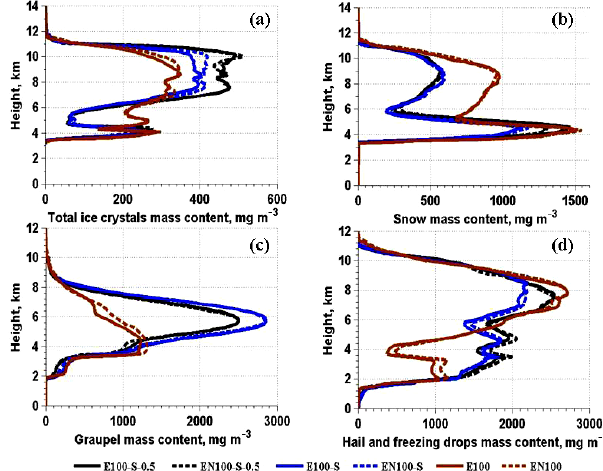
Figure 9. Vertical profiles of the maximum values of mass content: (a) total ice crystals, (b) snow, (c) graupel, and (d) total hail and freezing drops in the simulations with low CCN concentration. The profiles are obtained by averaging over the time period of 3420–